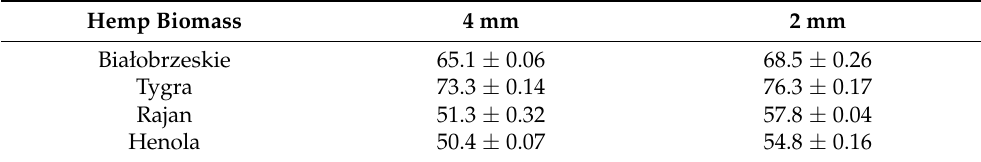
Table 1. The amount of reducing sugars (mg · g − 1 ) released after an enzymatic test depending on the fraction size.